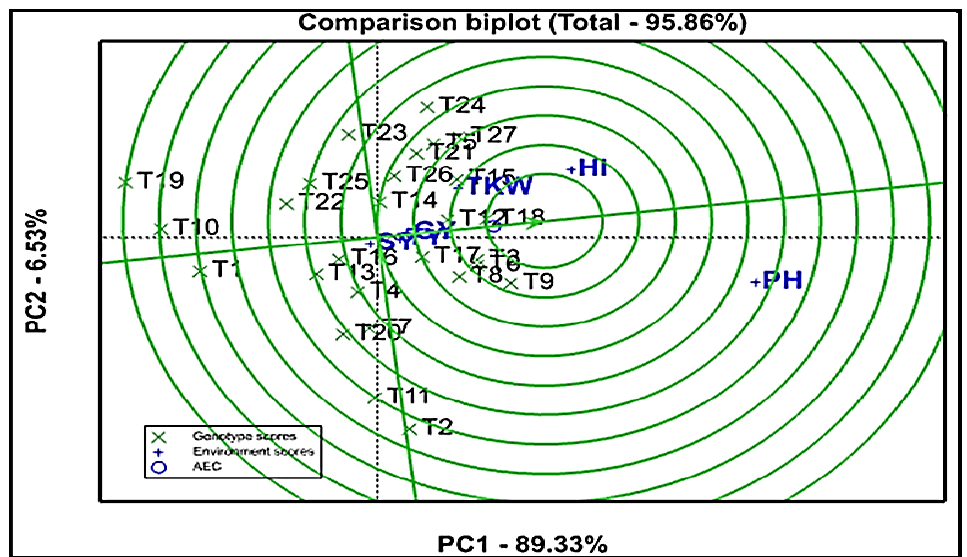
Figure 6. Ideal treatment of TT bi-plot, showing the ranking of twenty-seven barley irrigated-fertilizer combination treatments for various measured traits. Abbreviations: Biological yield (BY), grain yield ton ha −1 (GY), straw yield (SY), 1000-kernels weight (TKW), plant height (PH), and harvest index% (HI). T1 to T 27 refer to Table 3 .